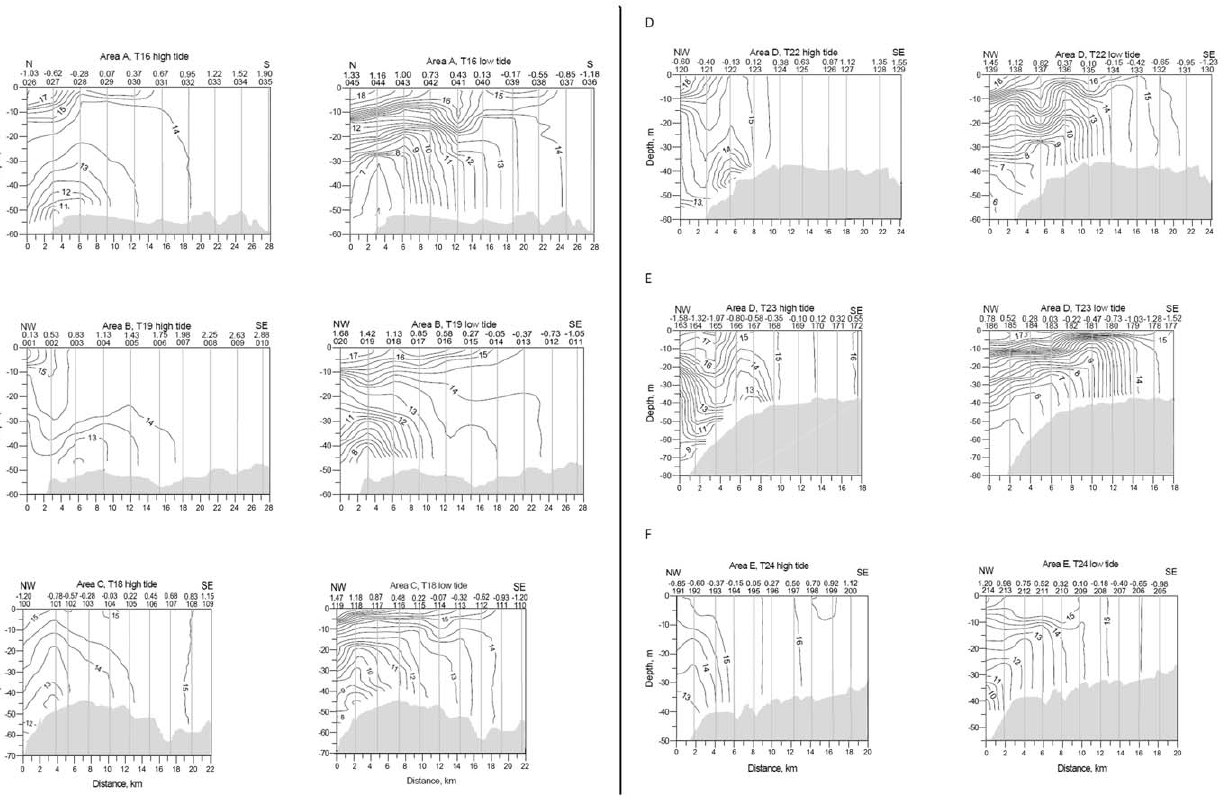
Figure 7. Water-column cross sections along CTD transects in study areas A-F. Data were obtained from the northern margin of Georges Bank in August 2009 (Figs. 2,3,4,5,6). Stations were occupied in numerical order, from off-bank to on-bank around high tide and from on-bank to off- bank around low tide. Temperature contour interval is 0.5 u C. All sections are oriented from N or NW (left, off bank) toward S or SE (right, on bank). Numbered vertical lines represent CTD temperature profile stations. Depth of deepest station is not shown when results of contouring were unreliable due to a large change in depth of seabed between some off-bank stations. See Table S1 for station depths. Numbers above station numbers indicate times of temperature observations in hours before (-) and after ( + ) high tide or low tide, depending on which tide is represented.